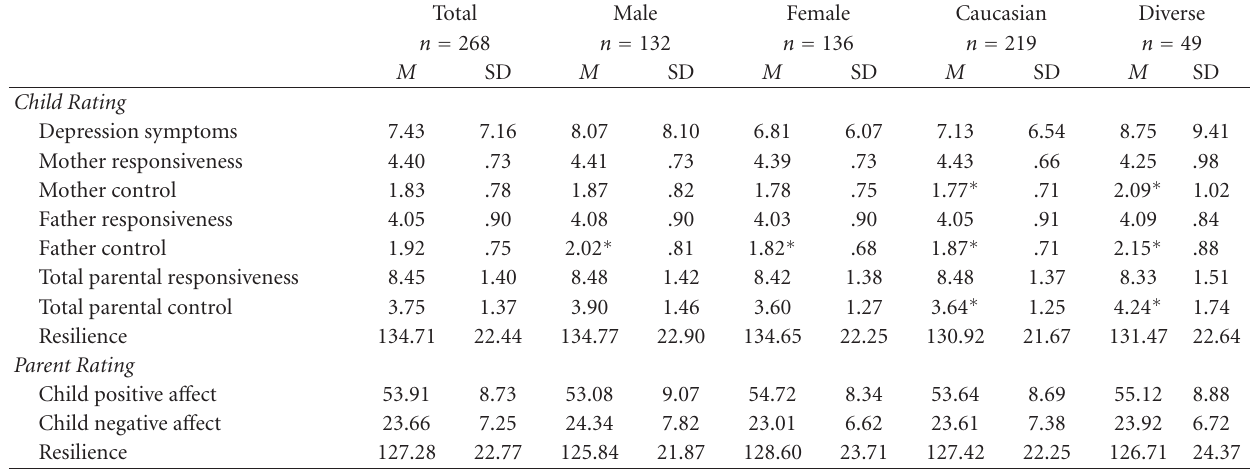
Table 1: Means and standard deviations for parent and child ratings of mood and emotional resilience and child rating of parenting behaviours by sex, ethnicity and for total